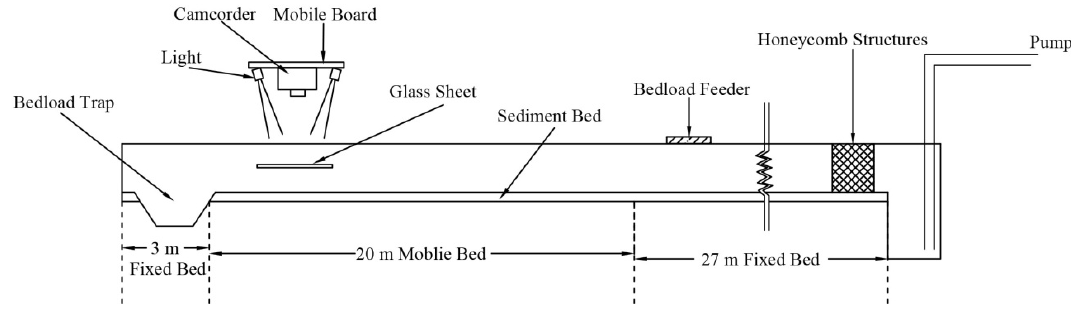
Figure 1. Schematic plot of the experimental flume (drawing not to scale). The flow was from right to left. Table 1. Particle size distribution of the experimental sand / gravel Table 1. Particle size distribution of the experimental sand/gravel mixture.